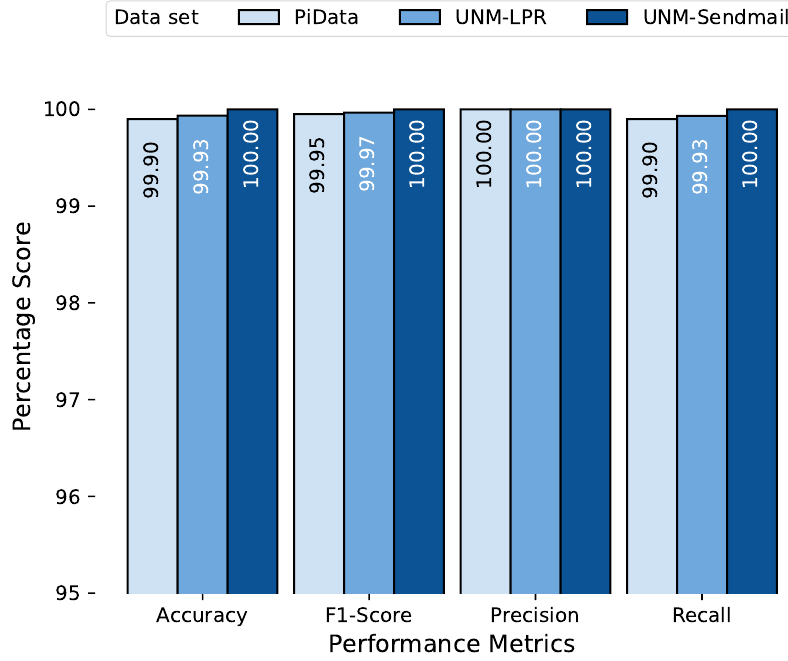
Figure 9. Results of the executing proposed anomaly detection approach over test data of all three